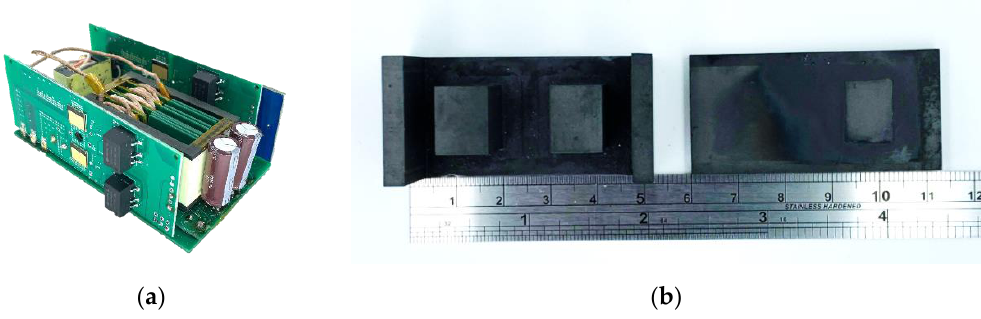
Figure 14. Phase-shifted full-bridge converter with an integrated transformer: ( a ) Physical circuit; ( b ) Ferrite core. Table 3. Design parameters of phase shift full-bridge converter.